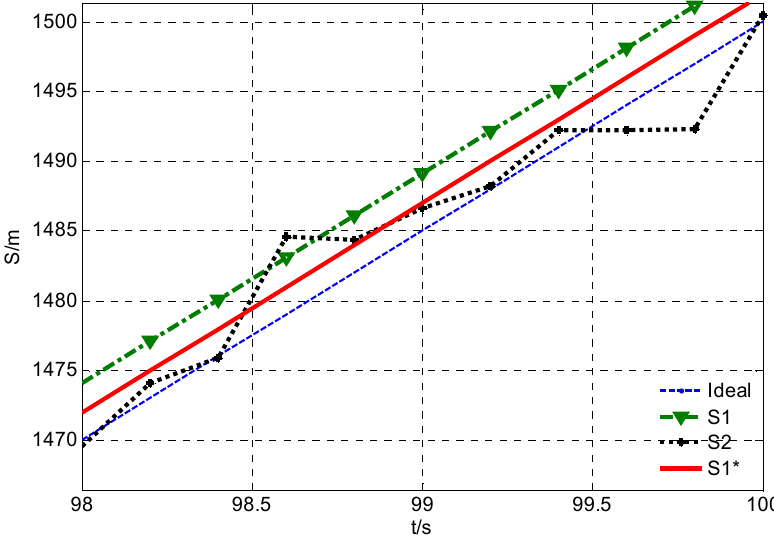
Figure 5. Distance histories before and after LEC vs . theoretical distance history.